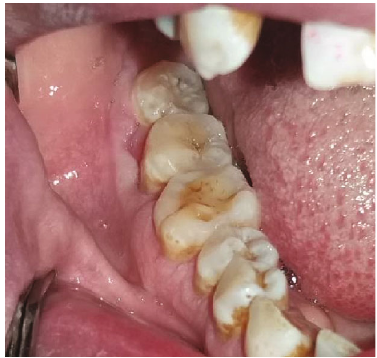
Figure 5: Healing 10 days postoperatively; complete healing of the soft tissue.